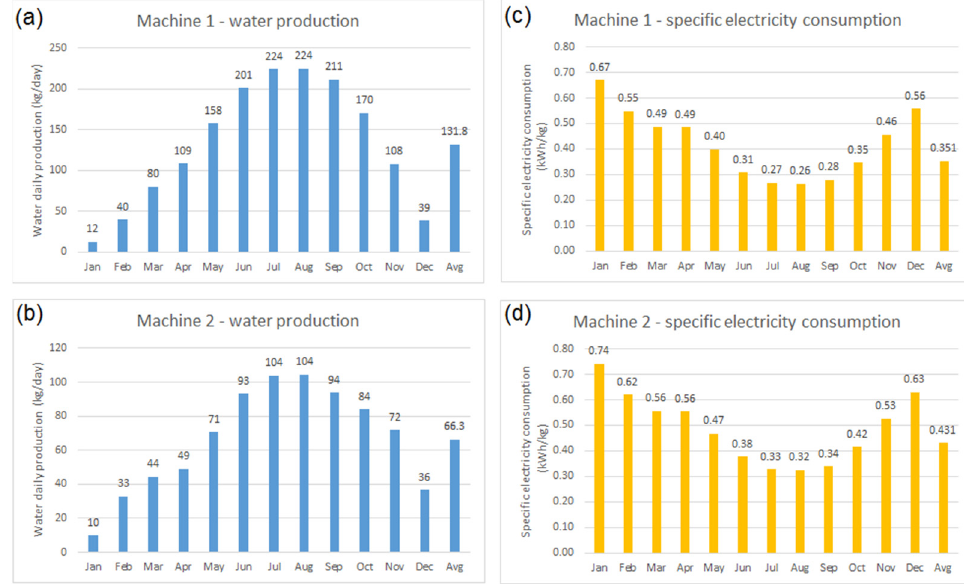
Figure 1. Average daily water production of ( a ) Machine 1 and ( b ) Machine 2; average specific electricity consumption of ( c ) Machine 1 and ( d ) Machine 2. Avg = average.